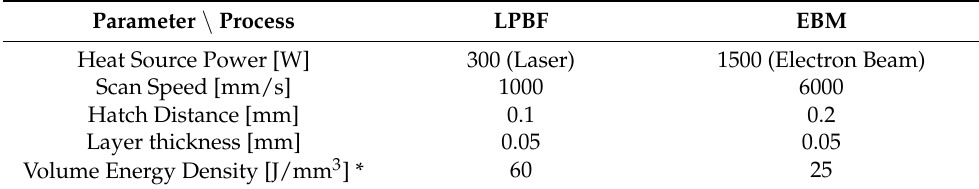
Table 2. Utilized process parameters for LPBF and